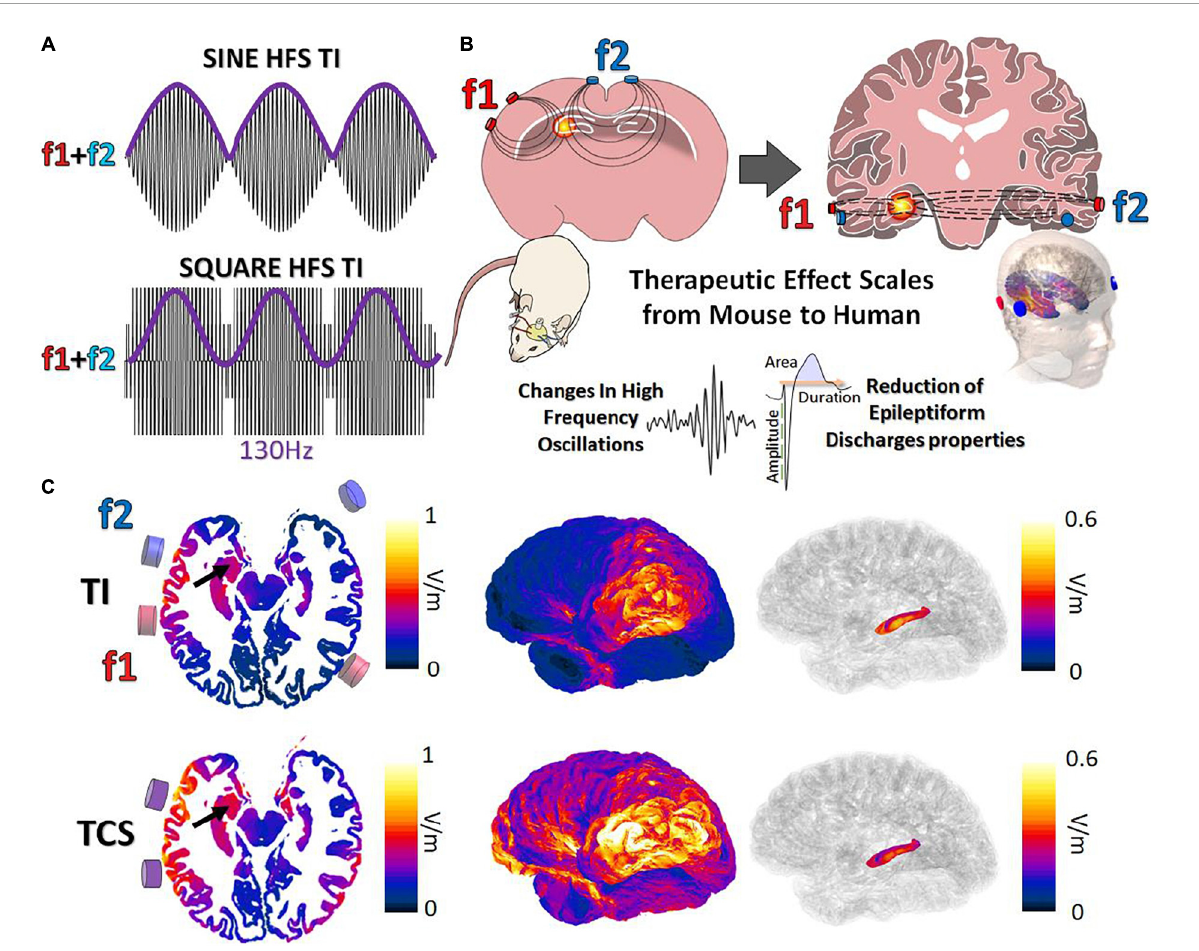
FIGURE1 Forms of temporal interference and ability to scale to larger subjects. (A) Classically, TI has been created via a combination of 2 kHz sine waves (f1:1,300 Hz f2:1,430 Hz, envelope = 130 Hz). We investigated the impact of TI by mixing square waves (PWM-TI). (B) To provide TI stimulation, cortical electrodes (2 pairs) were placed on the cortex of mice and human skin. In both cases, the aim was to focally reach one side of the hippocampus and provide stimulation at depth. (C) Simulated TI envelope modulation amplitude distributions (along the direction of maximal modulation) and peak carrier field magnitude (bottom; TCS) and their corresponding surface field views. Arrows: